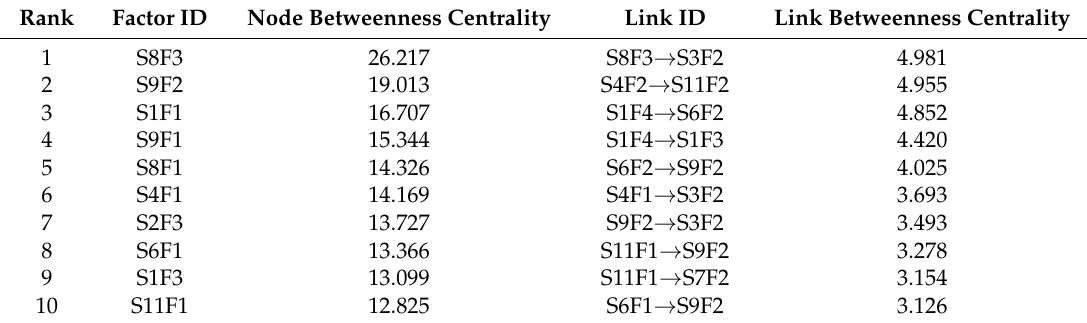
Table 4. The key factor related to betweenness centrality.